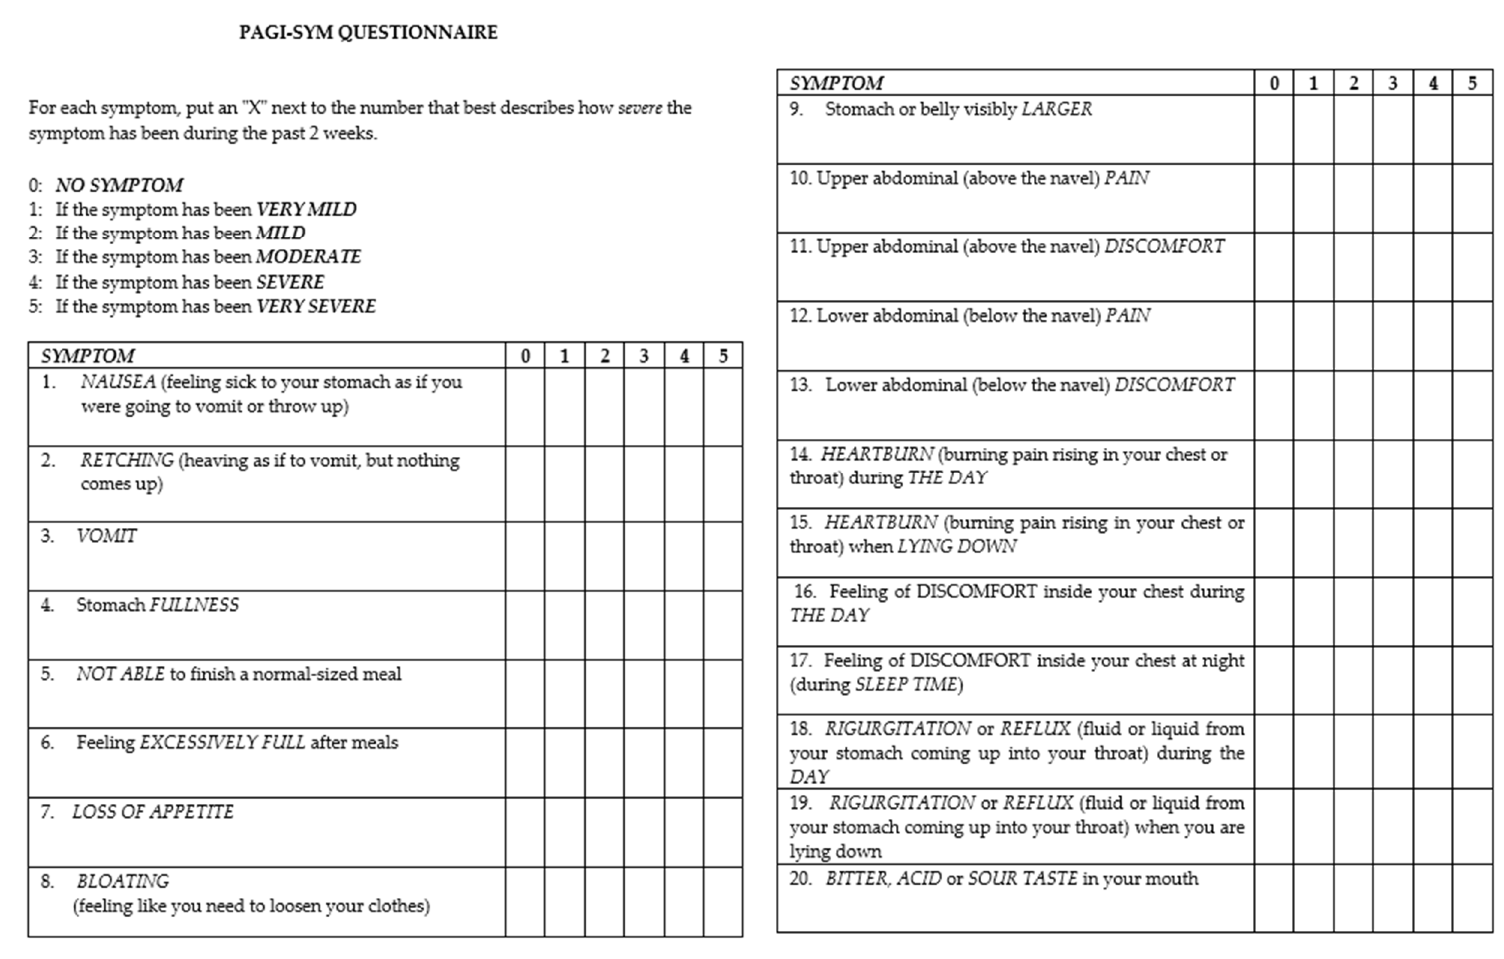
Figure A2. PAGI-SYM Questionnaire.